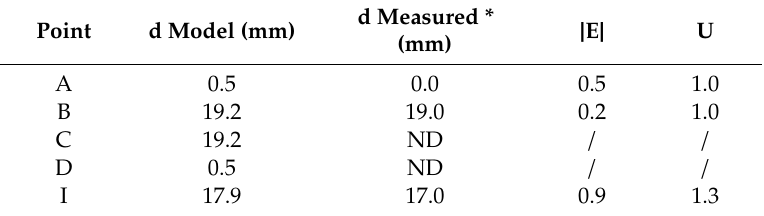
Figure 7. Displacements field at the final stage of the fire test (60 min); scale in (m). Displacements perpendicular to the door face, along y direction. Table 3. Comparison between model and measured displacements; error estimation and validation.